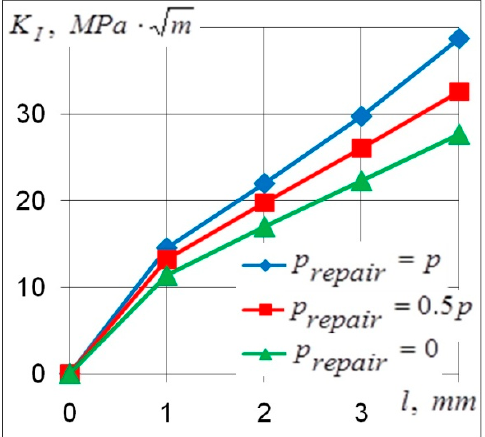
Figure 6. The dependence of the stress intensity factor on the depth of the defect.